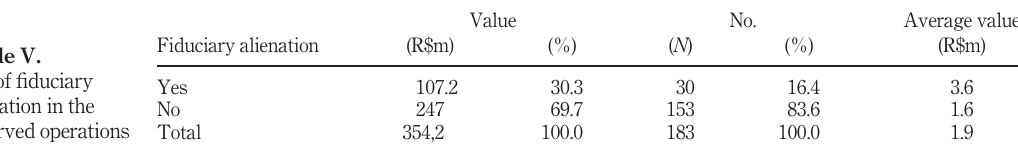
Table IV. Use of guarantee programs in the observed